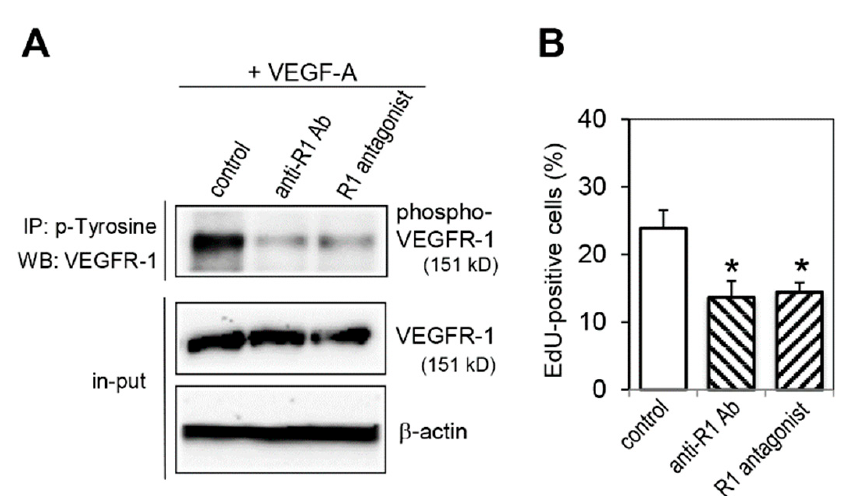
Figure 5. VEGFR-1 blockade decreases proliferation activity. ( A ) Inhibition of VEGFR-1 by anti-VEGFR-1 neutralizing antibody (anti-R1 Ab) and VEGFR-1 antagonist (R1 antagonist). Cells were treated with anti-R1 Ab, R1 antagonist or control IgG (control) in the presence of VEGF-A for 5 min. Phosphorylated VEGFR-1 was detected as described in legend to Figure 1. The same lysates (10% input) were immunoblotted with an anti-VEGFR-1 antibody to normalize the amounts of each sample. The levels of β -actin are shown as a loading control. ( B ) Quantification of EdU positive cells under VEGFR-1 inhibiting conditions. Cells were treated with anti-R1 Ab, R1 antagonist or control IgG for 24 h. Data are indicated by means ± SD ( n = 6–8). * p < 0.01, statistically significant decrease compared with the control cells.